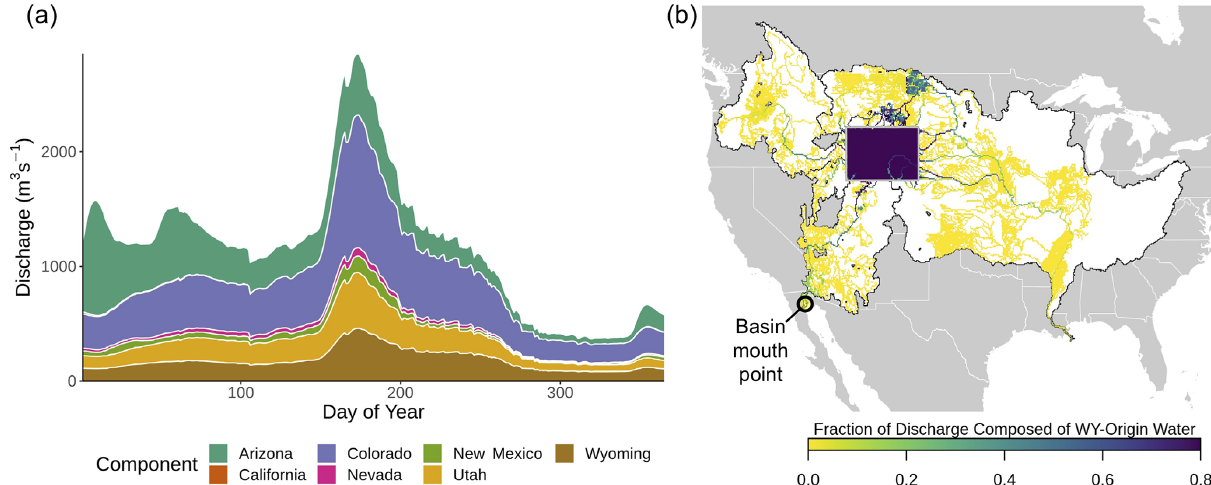
Figure 13. Demonstration of the WBM’s land surface attribute tracking function. (a) Discharge at the mouth of the Colorado River basin (basin mouth point shown in panel (b) . Colors show contribution of water from seven different US states, accounting for the movement, storage, and cycles of extraction occurring across the basin’s many upstream water uses. (b) Fraction of Wyoming (WY) waters in river discharge on 1 July 2009. Basins in the study domain are outlined in black; gray regions are not simulated; the state of WY is outlined in light gray. The state of WY appears dark in (b) because nearly all river discharge within the state of WY is > 80% WY-origin water. Where rivers enter WY, such as the North Platte River, the color lightens as a larger portion of non-WY water enters the state boundaries; as more WY-sourced water is added to those rivers, the color becomes progressively